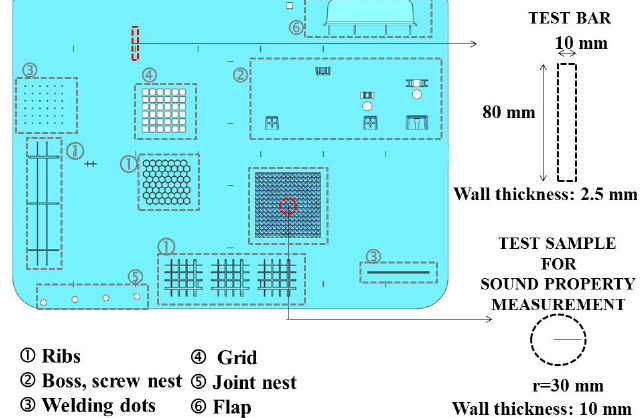
Figure 1. Experimental part design with elements of (1) ribs, (2) boss-screw nests, (3) welding dots, (4) grids, (5) joint nests, (6) flaps, and sound transmission loss. Locations of standard ISO test spec- imens for mechanical, scanning electron microscopy, and sound transmission loss measurements marked with dashed red line.